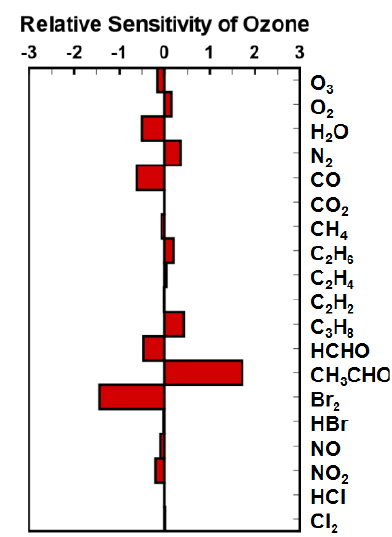
Figure 5. Relative concentration sensitivities of ozone under an initial NO By analogy to CH , reaction of OH with many hydrocarbons (RH) leads to the formation of alkyl 4 peroxy radicals (RO ) through (R19). The formed alkyl peroxy radicals are able to oxidize NO to NO 2 which is able to compensate ozone through the following photolysis of NO.